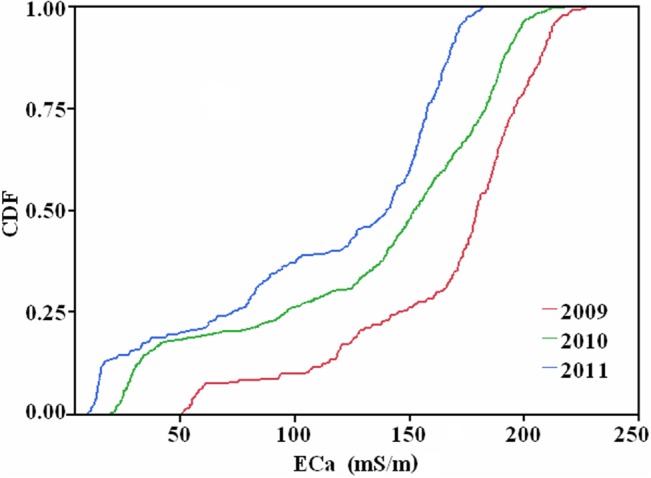
Plot of cumulative distribution function (CDF) of ECa (mS/m) in 2009, 2010 and 2011.